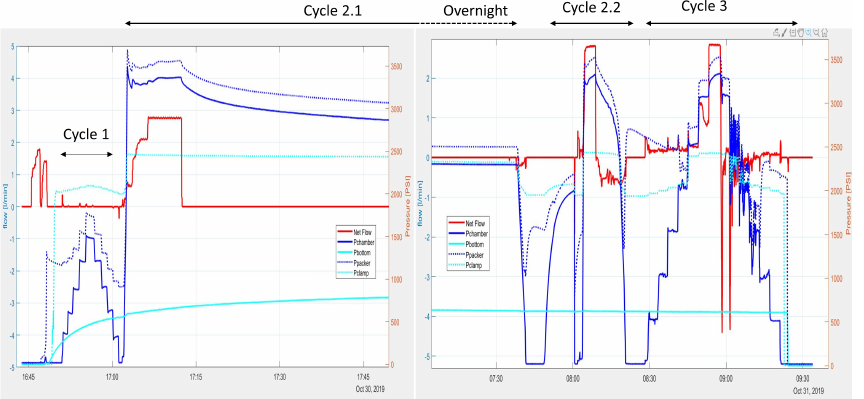
Figure 14. Borehole TV 4100 test 7 injection tests [47]. Table 4. Description of injection cycles of test 7 [47].